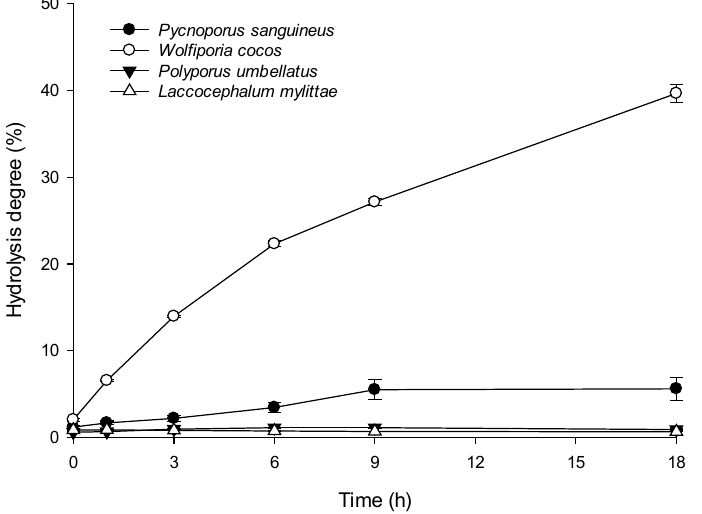
Figure 7. Hydrolysis degree of Polyporaceae hydrolysate by β -1,3-glucanase from Y. lipolytica transformant (pYLSC1- 13g ).